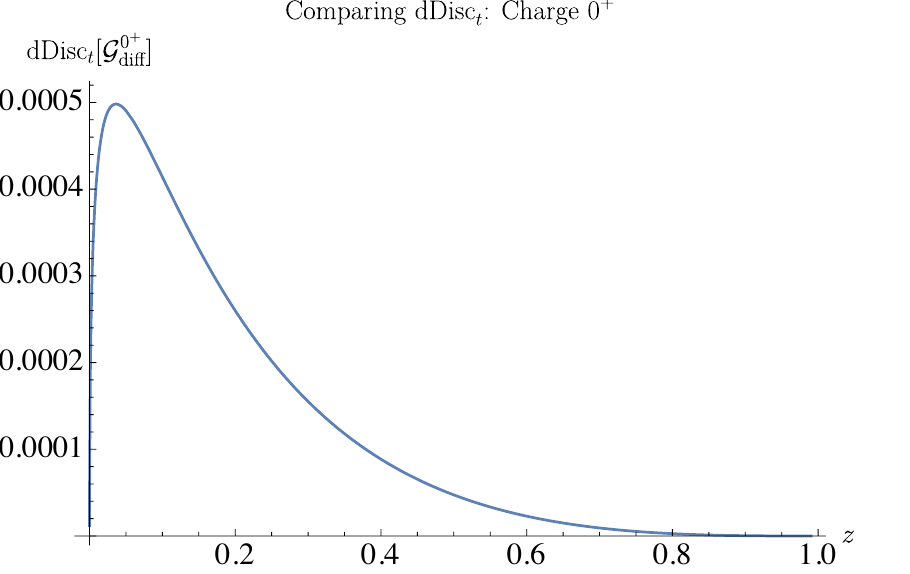
Figure 19 . We study the e(cid:11)ect of the double-twist operators on dDisc t [ G 0 + the di(cid:11)erence between including or not including them is small.